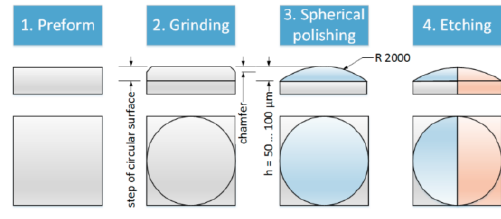
Fig. 1. Spherical Polishing process. The spherical shape of the specimen is measured by a contact stylus profilometer. Due to the single profiles the depth of removal at any distance from the center of the specimen is provided.